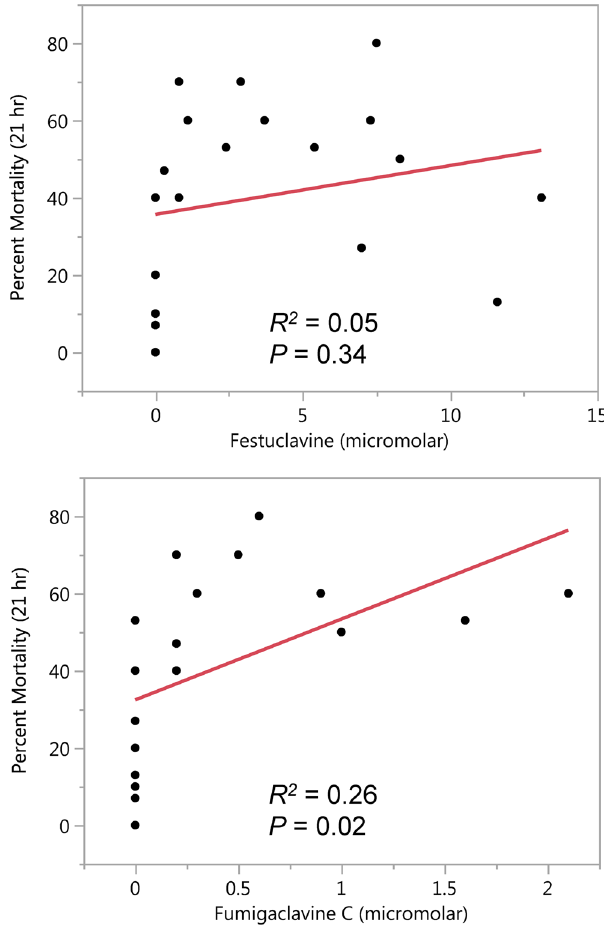
Figure 5. Correlation of ergot alkaloid concentrations in individual N. fumigata conidial extracts with larval mortality resulting from injection of that extract. Mortality was assessed at 21 hours post inoculation because both wild-type strains (Af293 and FGSC A1141) required 21 hours to kill 50% of inoculated larvae when those larvae were incubated at 37 °C. Data points represent all trials conducted at 37 °C with Af293 and FGSC A1141 and the ergot alkaloid mutants derived from those